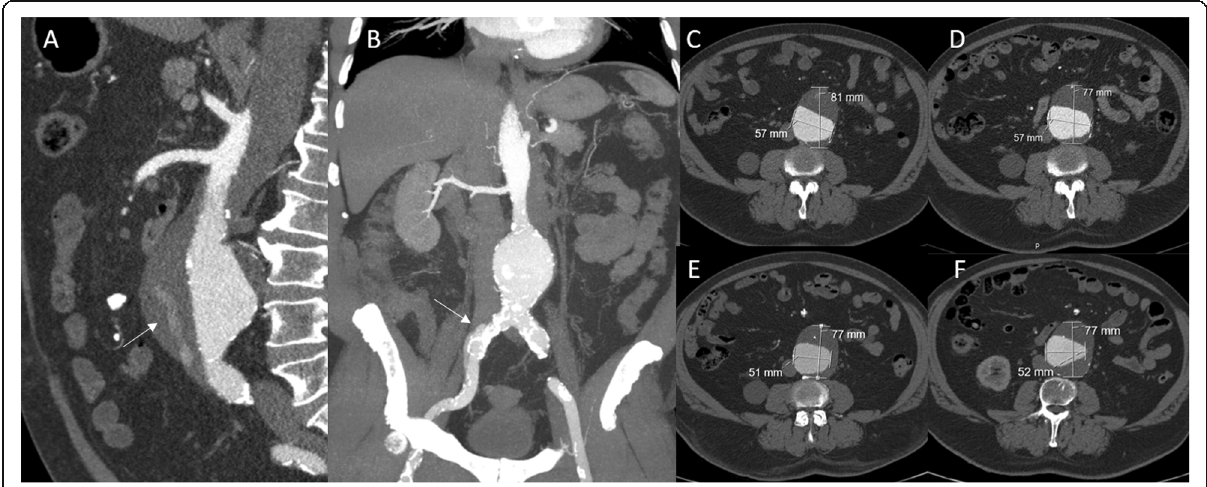
Fig. 2 Preoperative CT angiography of the post-dissection infrarenal aneurysm in the sagittal plane showing the filling of the false lumen (arrow) ( a ), coronal maximum intension projection (MIP) reconstruction ( b ) and transversal slides of a CT angiography of the post-dissection